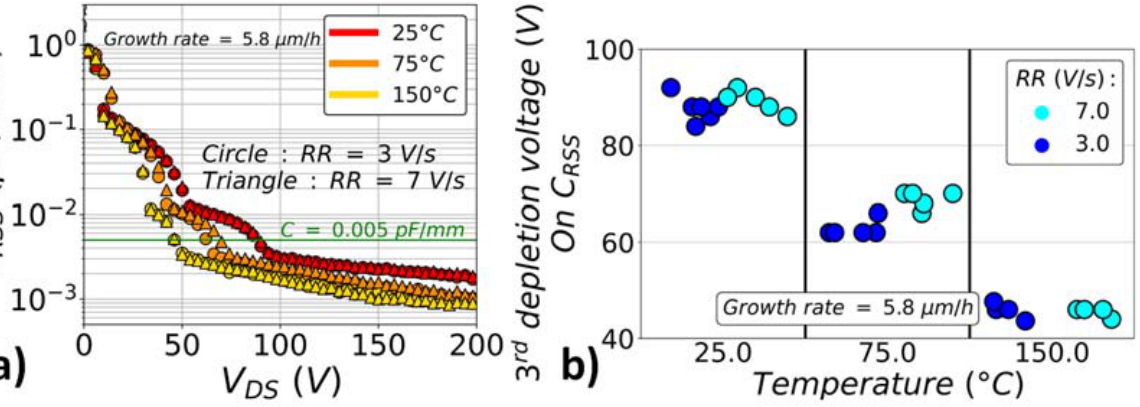
Figure 4. ( a ) Experimental C RSS (V DS ,T). ( b ) Temperature dependence of the third depletion voltage as a function of the ramp rate (the two ramp rates were tested with different devices).